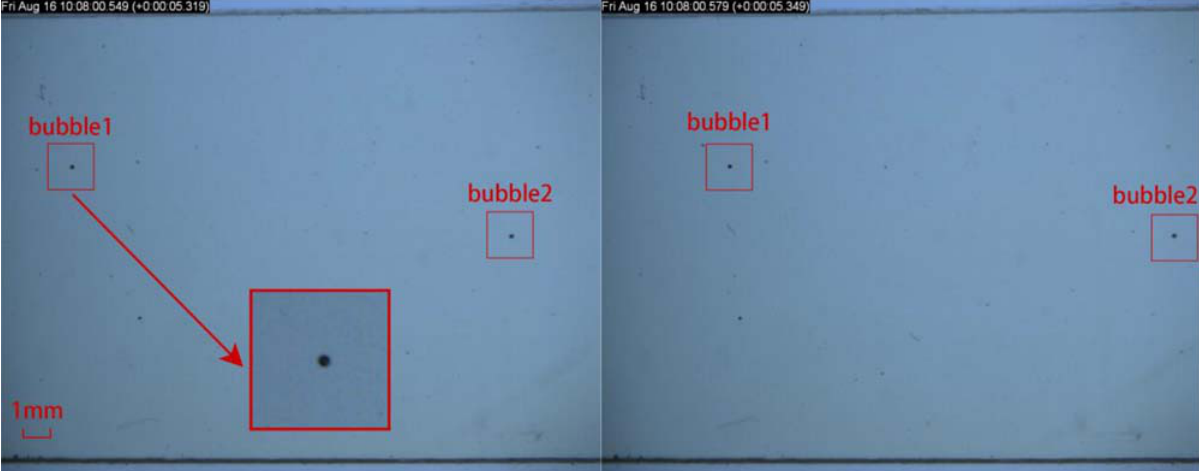
Fig. 6. Original images of bubbles.